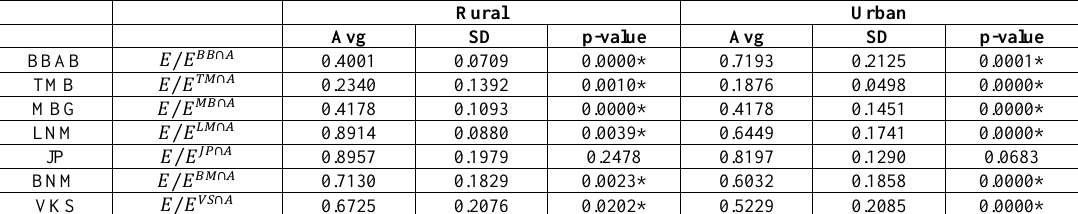
Table 8. The average impact of university and location factor on 𝐸 and its